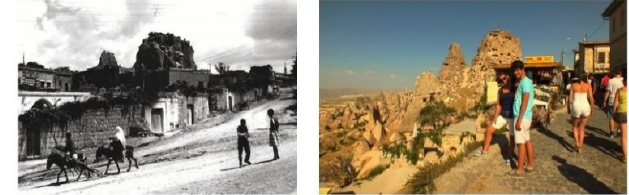
Figure 2. Revitalization of Uçhisar (Uchisar Municipality, 2019a).